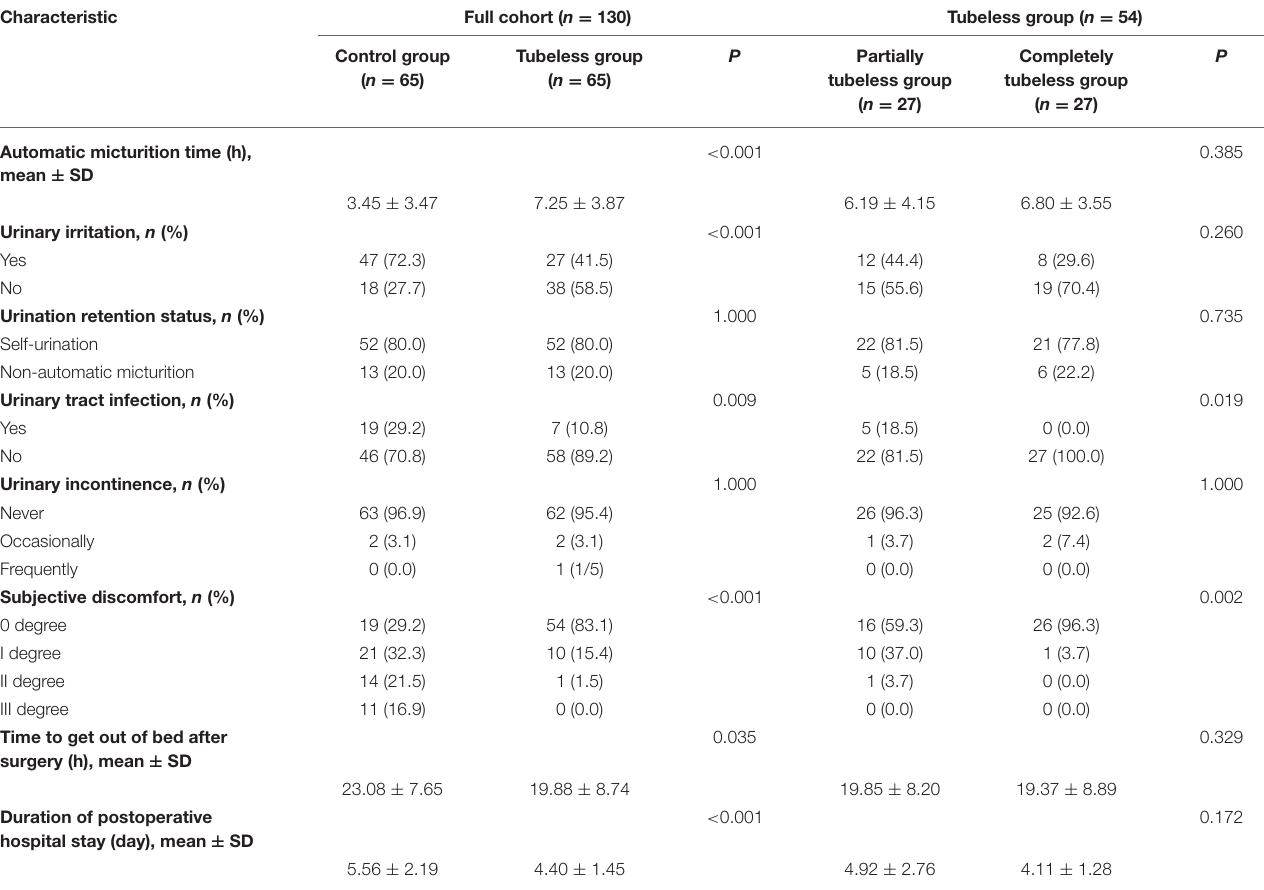
TABLE 3 | Operative parameters and postoperative recovery of our study population after PSM.